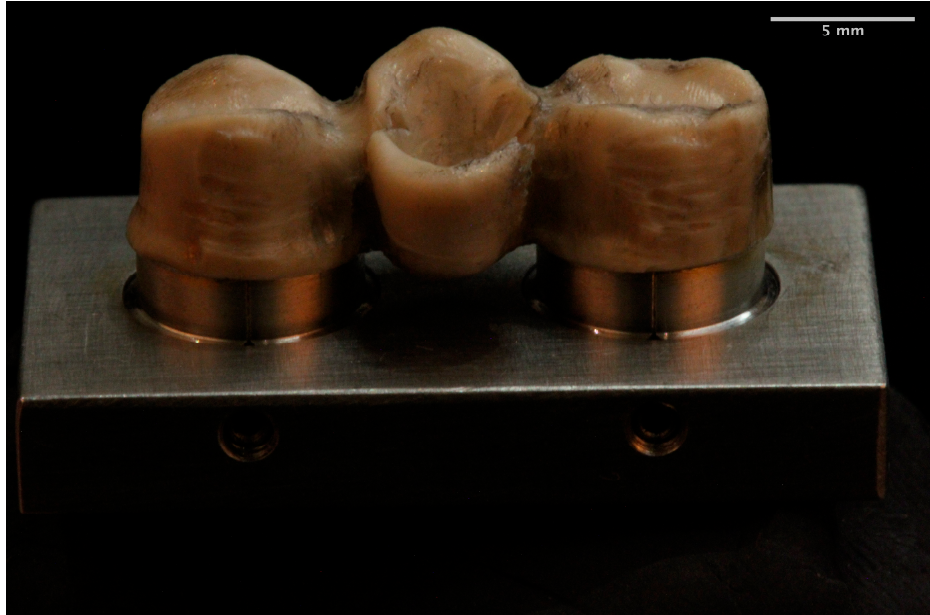
Figure 5. PEEK framework fracture.